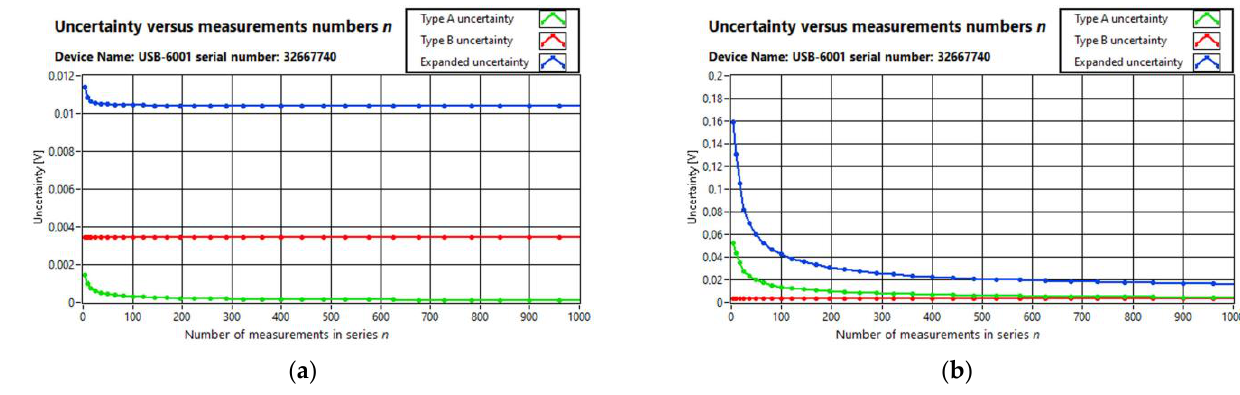
Figure 10. Uncertainties obtained from the measurements for the tested module NI USB-6001: ( a ) at low interference level, ( b ) at high interference level.